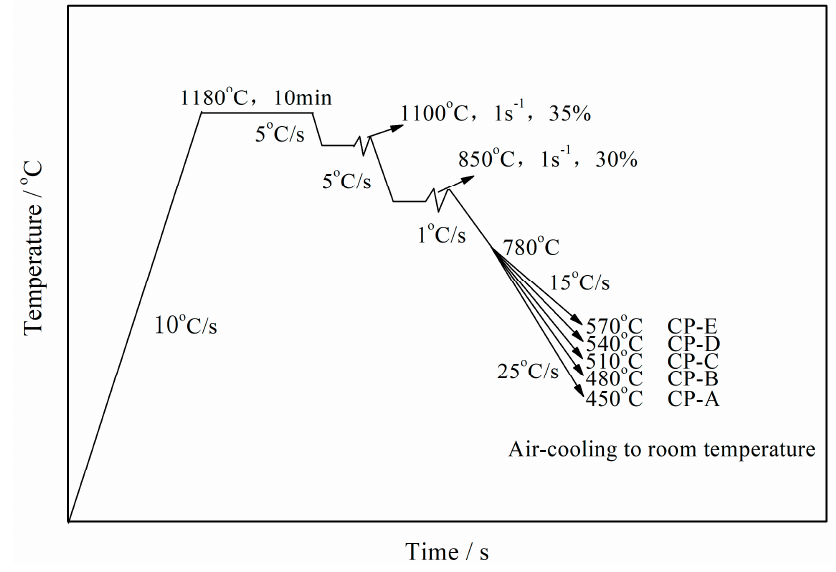
Figure 1. Schematic schedule for the simulated TMCP with a different cooling path in Gleeble.